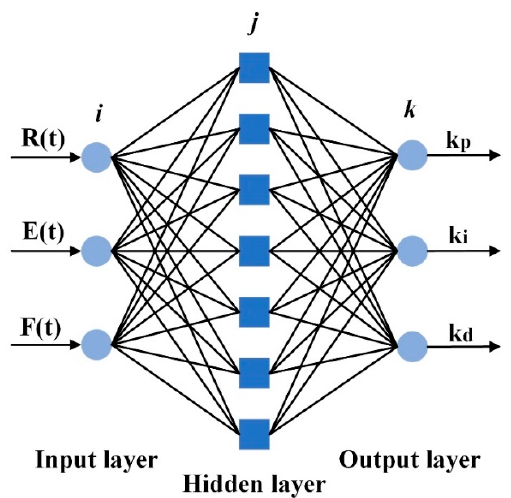
Figure 7. Schematic diagram of the neural network ANN1’s structure, part of the BPNN-PID con- troller depicted in Figure 6.